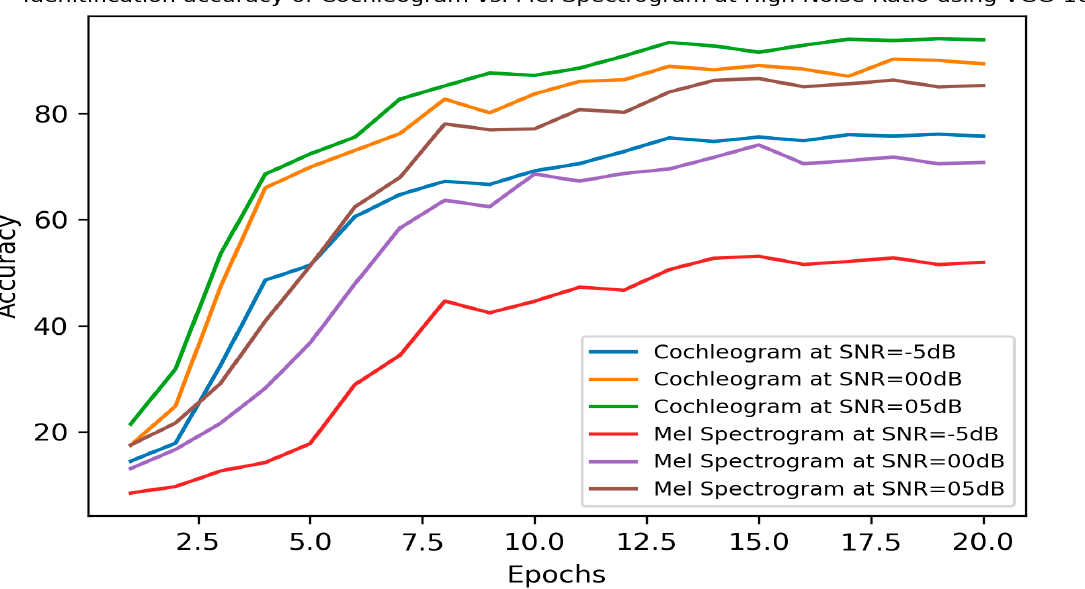
Figure 8. Speaker identification performance of Cochleogram vs. Mel Spectrogram at high noise ratio using VGG-16.